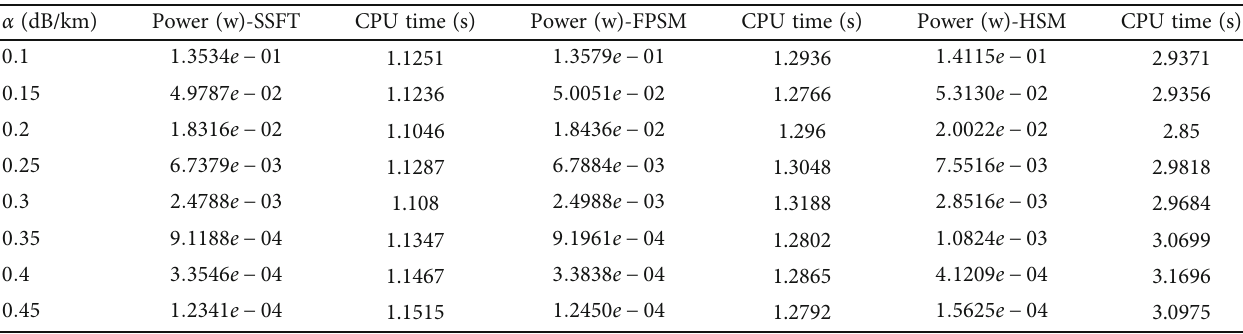
Table 4: A comparison of the pulse powers using the split-step Fourier transform (SSFT), the Fourier pseudospectral method (FPSM), and the Hopscotch scheme (HSM), at a distance z = 20 km, computed at di ff erent attenuation constants values α from 0 : 1 to